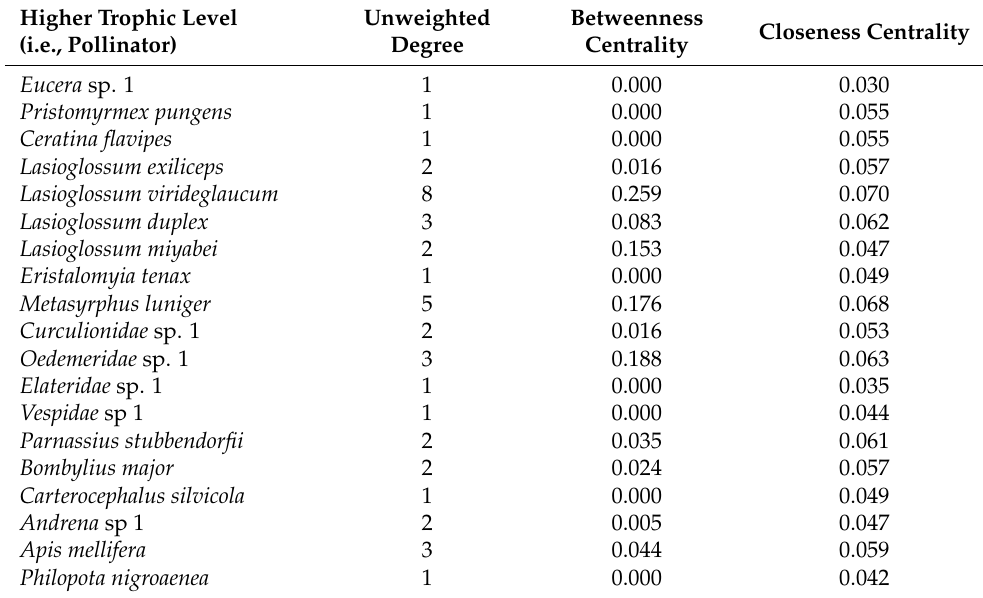
Table 4. Unweighted degree and centrality scores (BC: betweenness centrality, CC: closeness cen- trality) for pollinators that occurred in the Cypripedium guttatum habitat (the Manhangjae site) in the Republic of Korea.